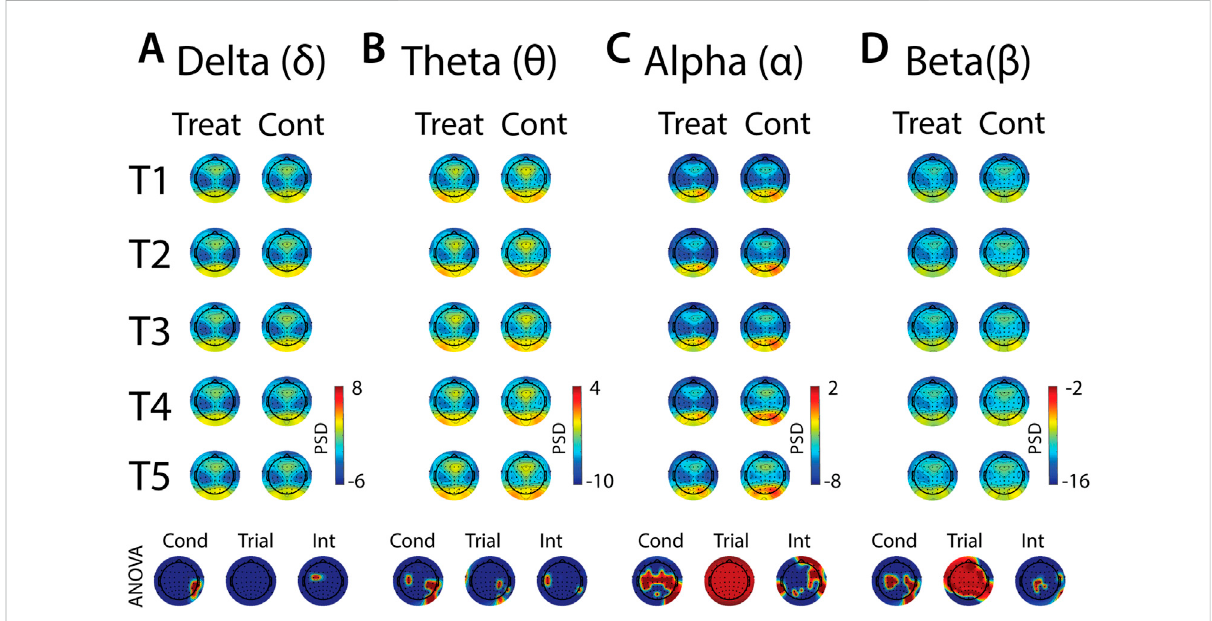
FIGURE 9 Effects of treatment and repeated trial exposure on anticipatory neural activity. Topographic plots in each panel (A – D) depict pre-exposure oscillatory neural activity in the delta, theta, alpha and beta frequency bands, respectively. Each panel contains separate columns of plots for the treatment and control conditions, with each repetition trial (T1-T5) represented by each row. Each plot depicts brain activity averaged across the baseline period. Condition (treatment, control) by trial (T1-T5) ANOVA results at each electrode are plotted at the base of each panel, with condition, trial and interaction effects depicted in separate topographic plots. Scalp regions overlaid in red indicate signi fi cant effects ( p null <